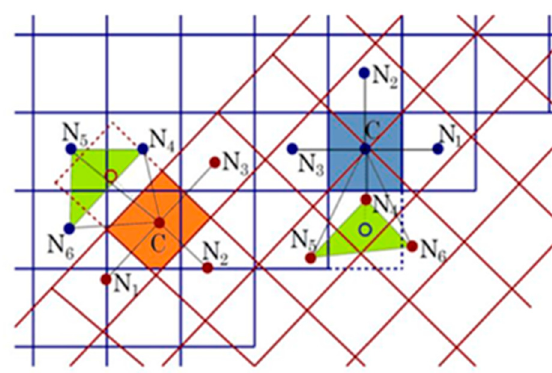
Figure 3 . Schematic diagram of overset grid boundaries.